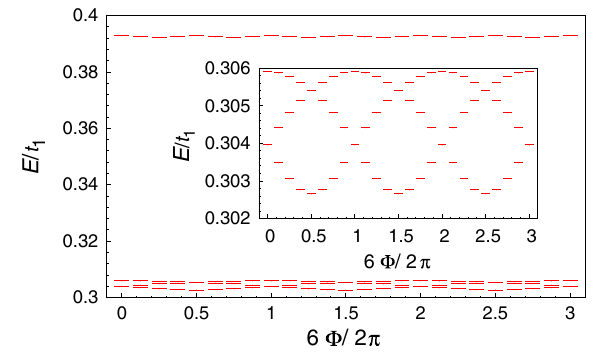
FIG. 2. Evolution of the 3-fold degenerate ground state upon flux insertion along the y direction at N ¼ 10 , N x ¼ 5 , and 6 . The 3-fold degenerate ground-states spectral flow into N y ¼ each other (inset) separated at each point in the flux insertion from the first excited state (the only one of the excited states shown here), which does not exhibit spectral flow with any of the other states.